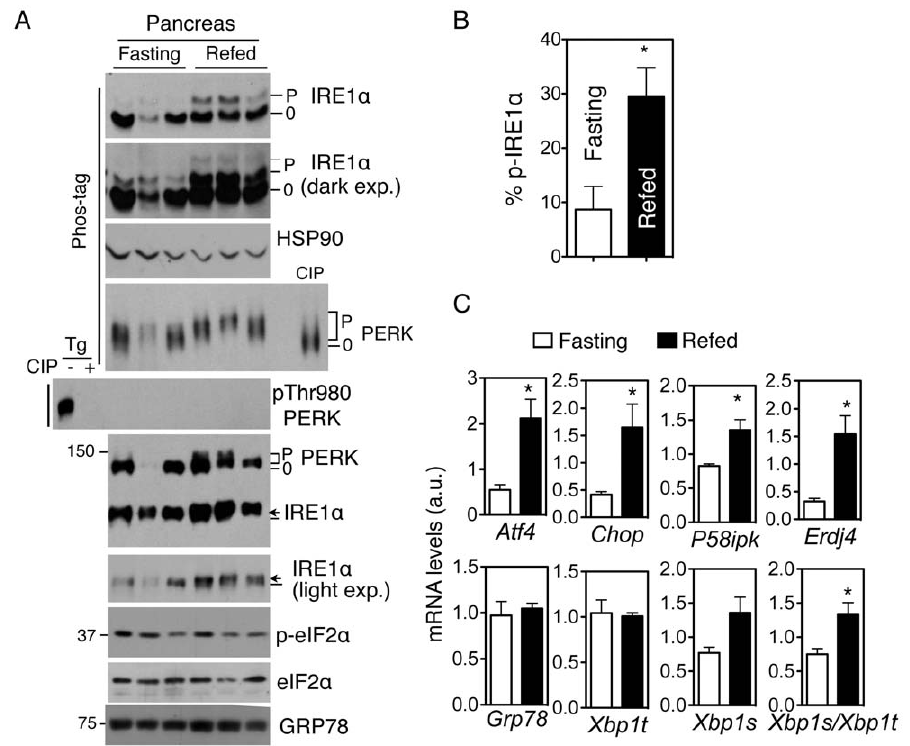
Figure 4. Fasting-refeeding induces mild ER stress in pancreas. ( A ) Immunoblots of lysates from the pancreas of wildtype mice either fasted or fasted followed by 2 h refeeding (refed). For the PERK blot, a mixture of all 6 samples treated with CIP were included as a control. For the p-PERK blot, Tg-treated MEF cell lysates with or without CIP treatment were included as a control. HSP90, a loading control. ( B ) Quantitation of the percent of phosphorylated IRE1 a in pancreas under fasting and refeeding conditions shown in A (N=4 mice per cohort). ( C ) Q-PCR analyses of UPR genes in the pancreas under either fasting or refeeding. Values are mean 6 SEM. Xbp1t , total Xbp1 ; Xbp1s/Xbp1t , splicing efficiency. N=3–4 mice. *, P , 0.05 using unpaired two-tailed Student’s t -test. Representatives of at least two independent experiments shown.